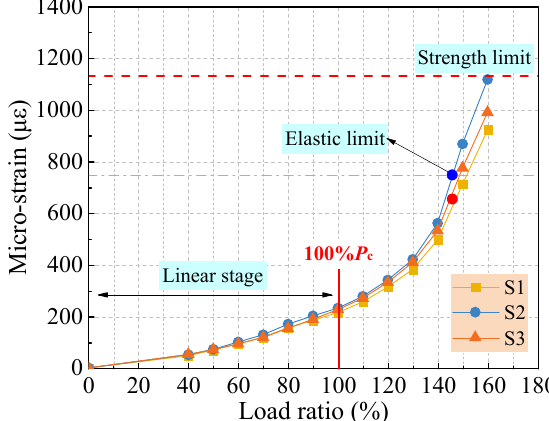
Figure 13. The load-strain relationship of the wire.